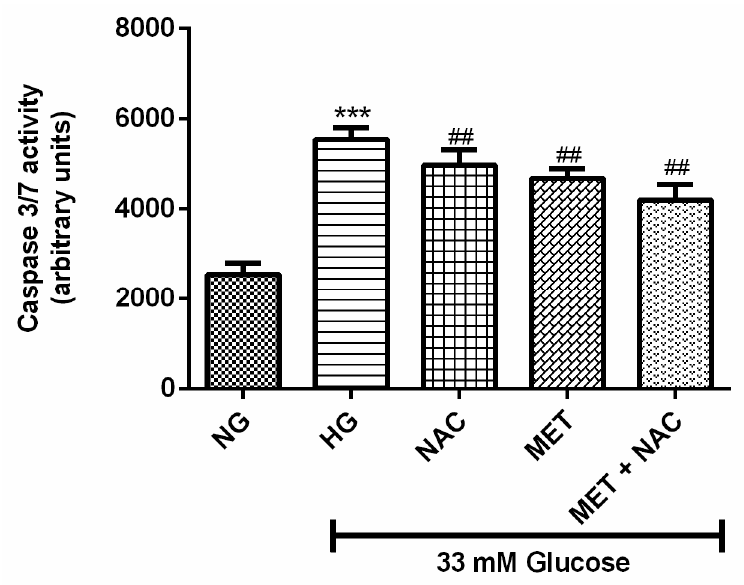
Figure 9. The combination effect of Metformin (MET) and N-acetylcysteine (NAC) on high glucose-induced caspase 3/7 activity. H9c2 cardiomyoblasts were cultured in high glucose (HG; 33 mM) for 24 h. Thereafter, cells were treated with NAC (1 mM), metformin (MET) (1 µM) and a combination of MET+NAC. Cells treated with normal glucose (NG) served as the vehicle control. Results are expressed as the mean ± SEM of 3 independent biological experiments with each experiment having 3 technical replicates ( n = 9). Significance is depicted as *** p ≤ 0.001 versus NG control, ## p ≤ 0.01 and ### p ≤ 0.001 versus HG control.